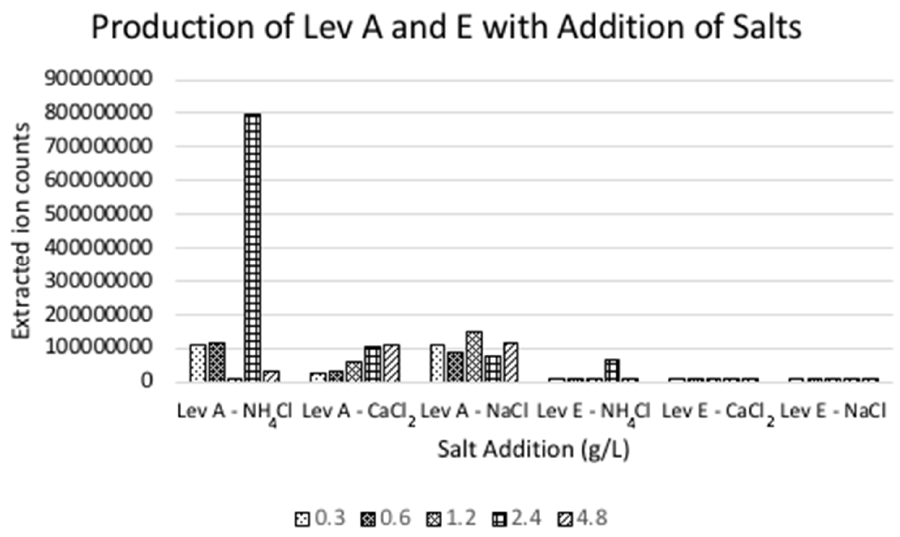
Figure 3. Integrated mass spectrometry peak areas of levesquamide A (Lev A) and levesquamide E